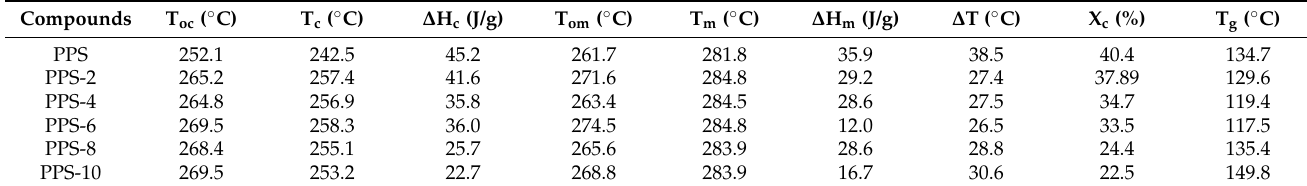
Table 7. Data obtained from the DSC trace of PPS@BC nanocomposites.